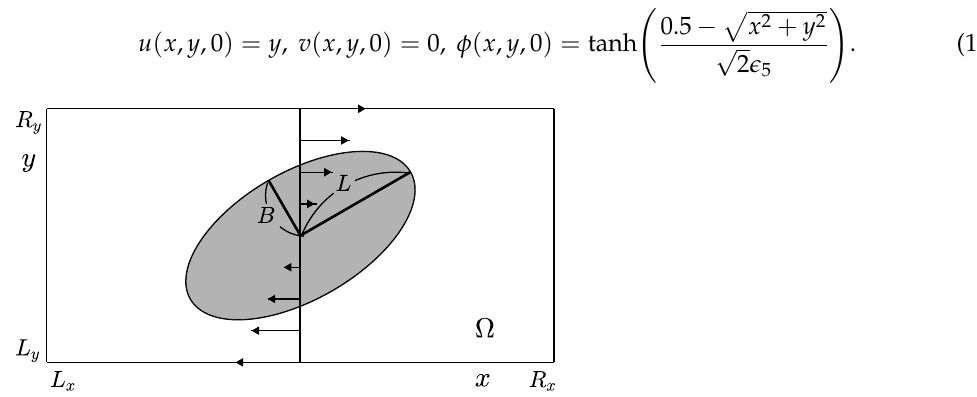
Figure 2. Schematic illustration of a droplet deformation in simple shear flow.